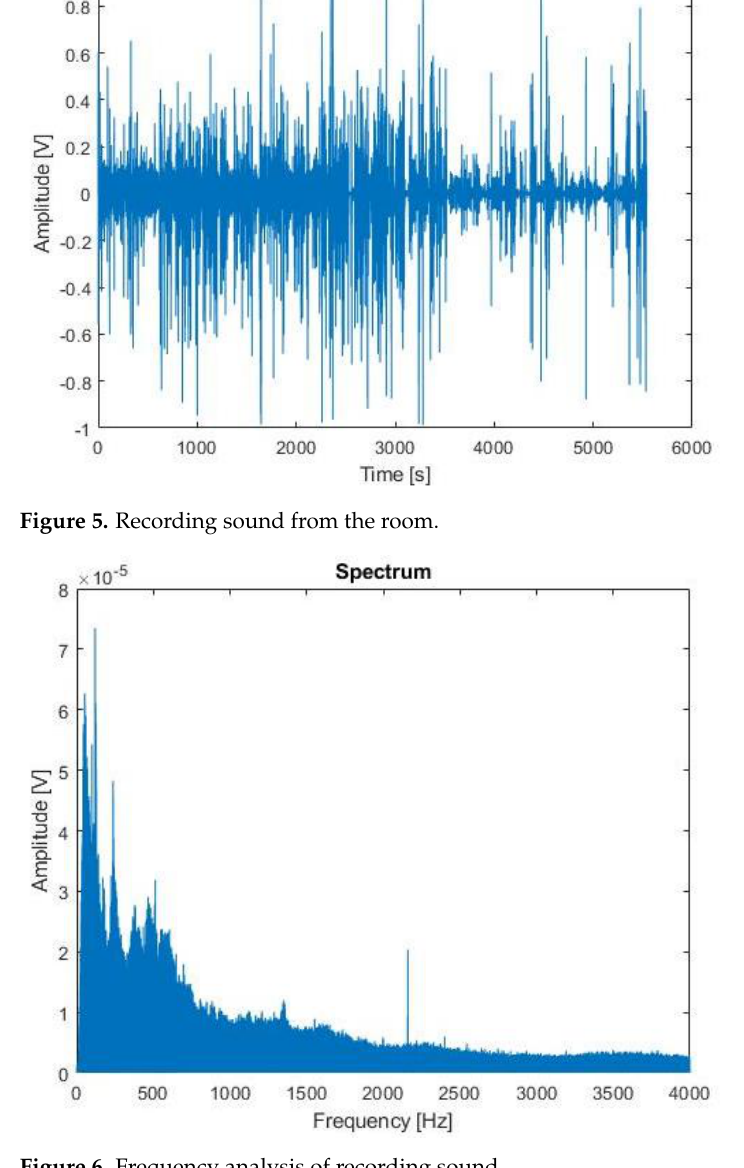
Figure 6. Frequency analysis of recording